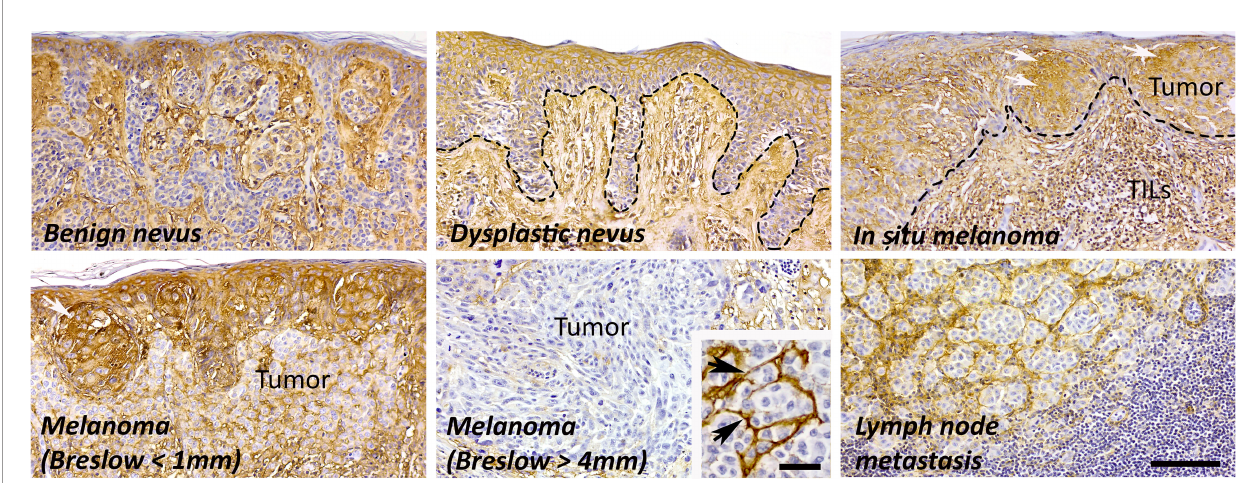
FIGURE 3 | The amount of hyaluronan in different stages of melanoma. In normal skin, both epidermis and dermis are highly hyaluronan positive, also melanocytes in the benign nevi show moderate or intense hyaluronan staining. The amount of hyaluronan increases in dysplastic nevi and in local tumors (white arrows) probably as part of the in fl ammatory reaction with elevated number of tumor in fi ltrating lymphocytes (TILs). In invasive melanoma, the amount of hyaluronan is decreased in tumor tissue but the stroma is strongly hyaluronan positive (black arrows). The hyaluronan staining pattern is similar in lymph node metastases and in deep melanomas (Breslow > 4 mm). Scale bar 100 µm, 40 µm in